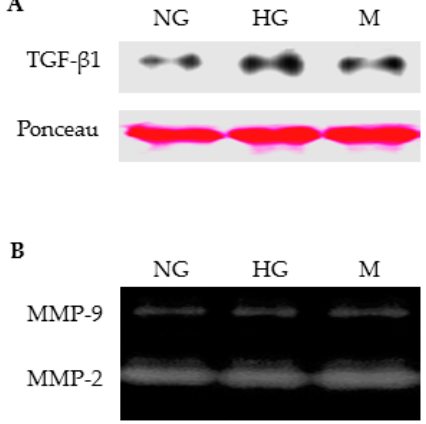
Figure 7. MMP-9 activity was increased in culture supernatants of primary rat TECs upon albumin stimulation. Gelatin zymography analysis confirms a dose-dependent increase in MMP-9 activity in the culture supernatants when the cells were incubated with rat serum albumin (RSA, 0.1–0.5 mg/mL) for 24 h ( A ) or 48 h ( A , B ), whereas MMP-2 activity was not altered. Values are mean ± SEM. n = 4; * p < 0.05 vs. untreated control group.